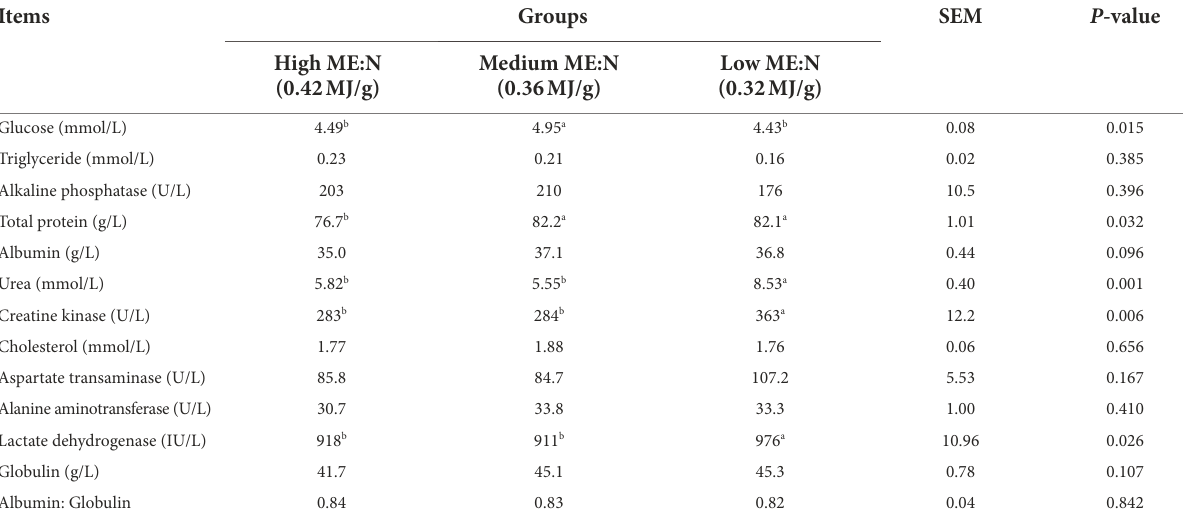
TABLE 4 Effect of dietary ME:N ratio on blood biochemical indices in